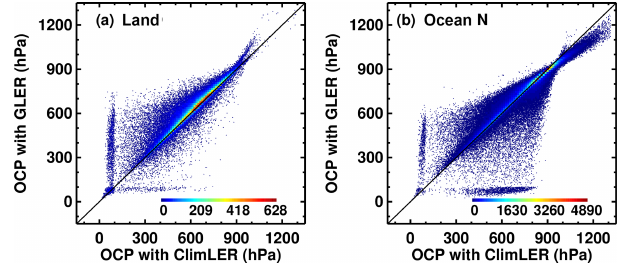
Figure 13. Two-dimensional histogram similar to Fig. 10 but com- paring OCPs retrieved with GLER with those retrieved with clima- tological LER.